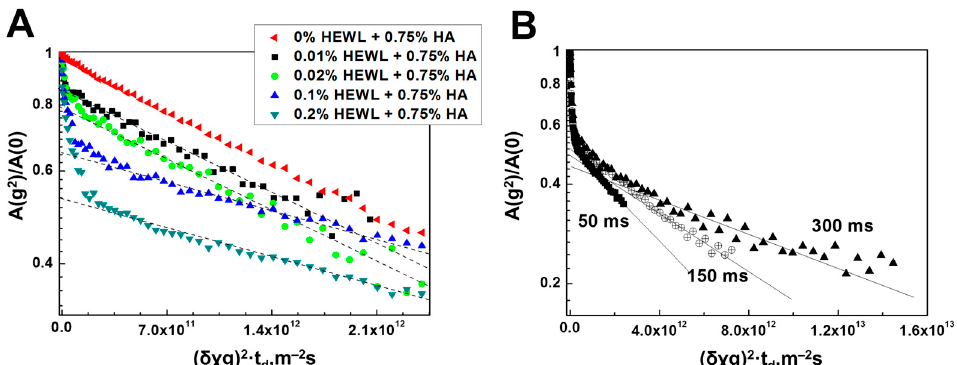
Figure 8. Diffusion decay of the spin echo signal for lysozyme and HA molecules at a HA concen- tration equal to 0.75% (wt.). ( A ) Diffusion decay at a diffusion time of 50 ms, obtained for samples with different protein contents (from 0 to 0.2 wt.%) by integrating signals located in the chemical shift region from 1.6 to 3.0 ppm. ( B ) Diffusion decays of the spin echo signal for an aqueous solution of HA and HEWL at a protein concentration of 0.2% (wt.) and polysaccharide concentration (0.75%) at various diffusion times of 50, 150 and 300 ms, obtained by integrating the signals of the proton spectrum (Figure 6) in the region of chemical shifts from 1.6 to 3.0 ppm.